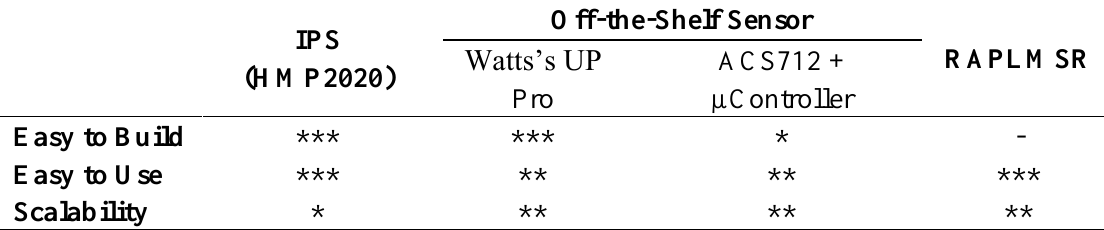
Table 3. Power Measurement